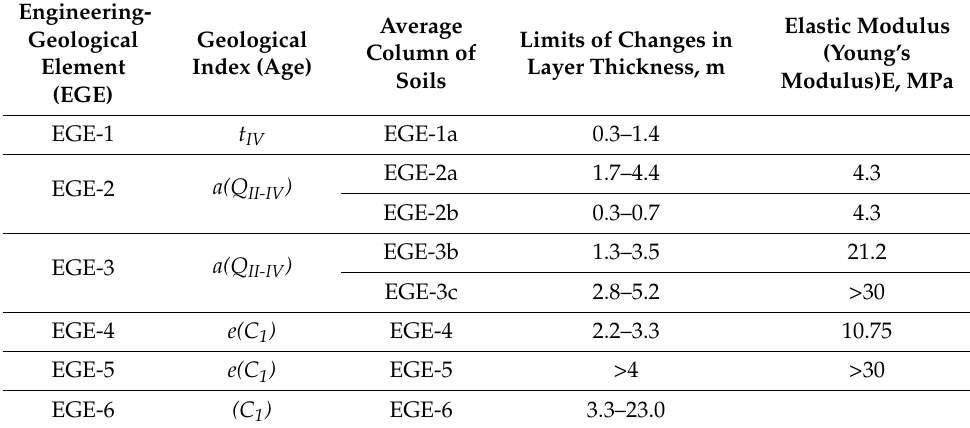
Table 2. Engineering geological stratification in Nur-Sultan